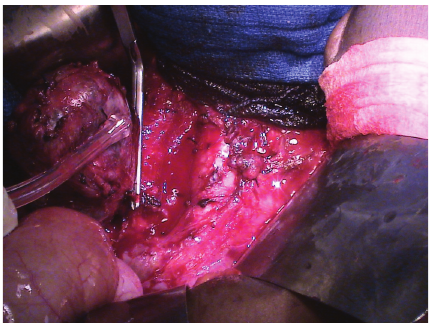
Figure 5: Intraoperative photograph demonstrating reconstructed inferior vena cava status after en bloc resection of attached para- ganglioma. Image courtesy of Tulane University School of Medicine, Department of Endocrine